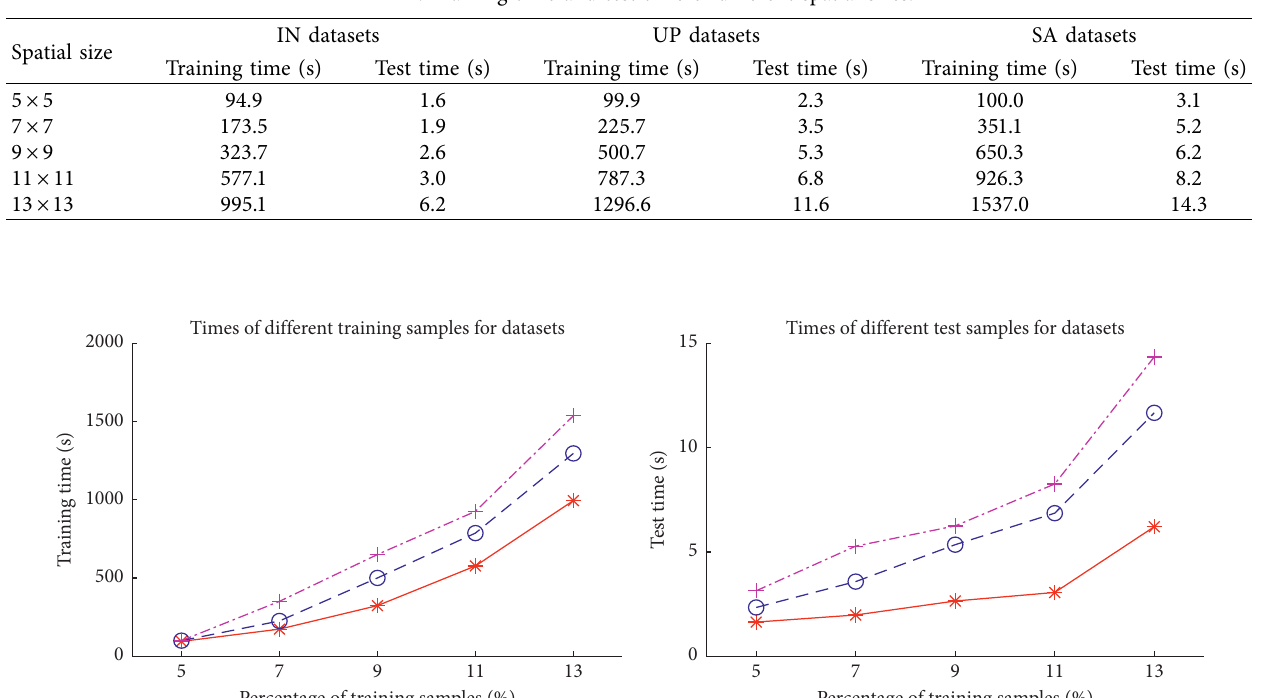
Figure 9: Accuracy of different spatial sizes: (a) IN; (b) UP; (c) SA. Table 4: Training time and test time of different spatial sizes.